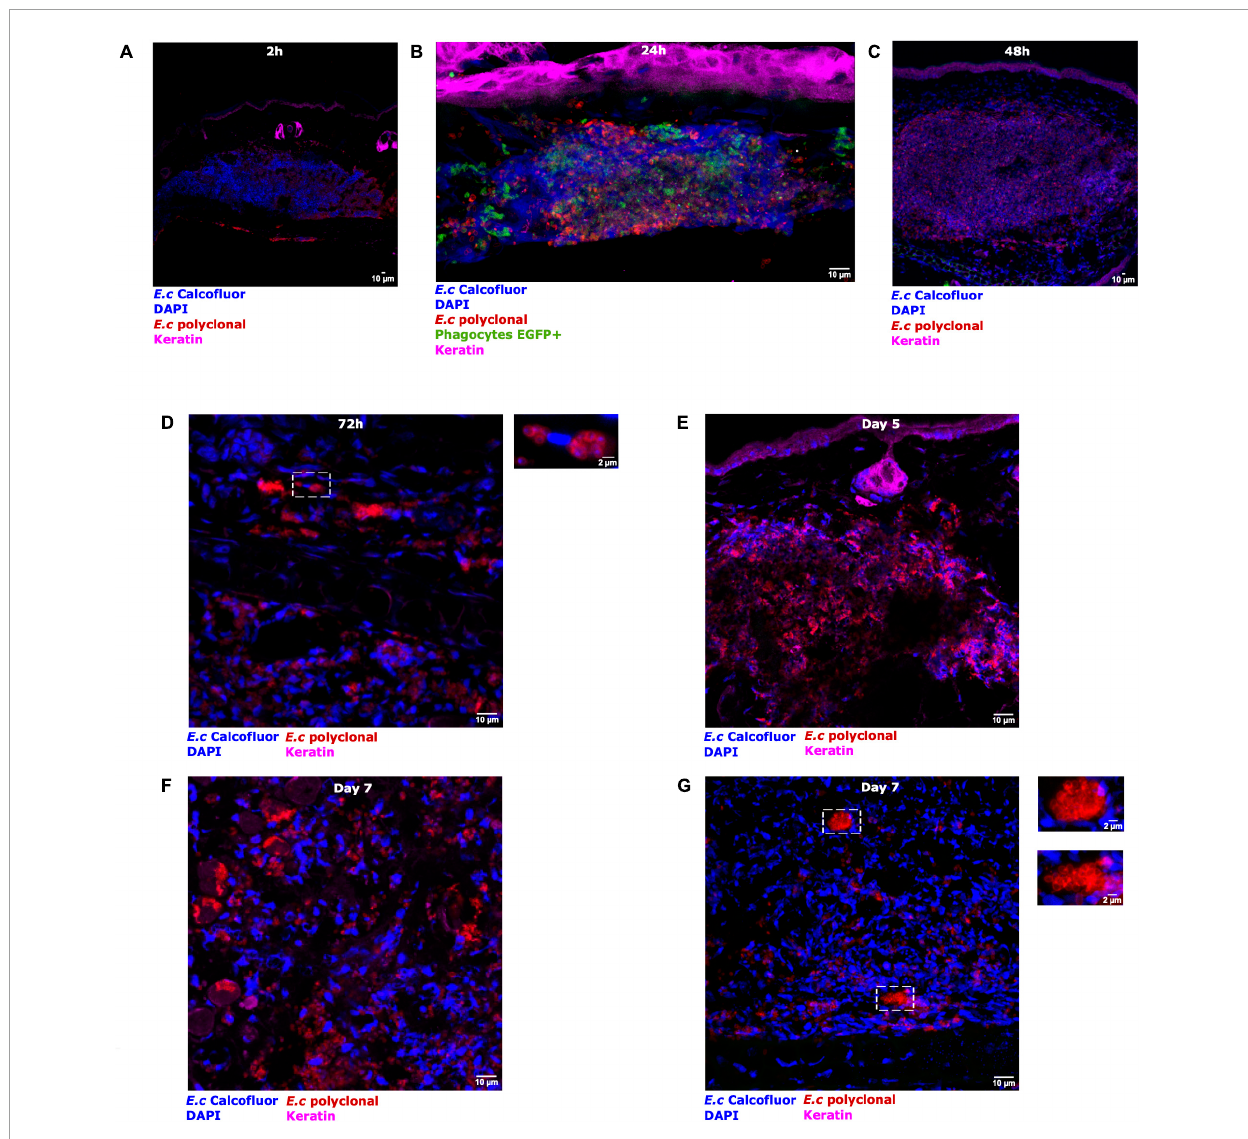
FIGURE6 Parasite development after micro-injection of Encephalitozoon cuniculi spores in the mouse ear pinna. Confocal immunofluorescence images of immunolabeling cryosections of infected ear tissues. LysM-EGFP mice (EGFP + phagocyte, green fluorescence signal) were inoculated with fluorescent E. cuniculi spores (CW +, blue fluorescence signal). Immunostaining was performed on cryosections obtained from 2 h to 7 days pi (A–G) . Magenta, red, and blue fluorescence signals correspond to specific labeling of keratin (K5 mAb), all parasite stages (anti- E. cuniculi polyclonal serum), and cell nuclei (DAPI)/spores (CW), respectively. A recruitment of EGFP + phagocytes is visualized in the injection area, around the spores inoculum 24 h pi (B) . Insets show infectious foci of developing parasites at 72 h [ (D) in close proximity to cell nucleus] and at day 7 pi (G) . [DAPI staining (G) ]. Three independent experiments, n = 30 tissues ( Ec ) and n = 12 tissues (PBS). Scale bar: 10 or 2 µ m